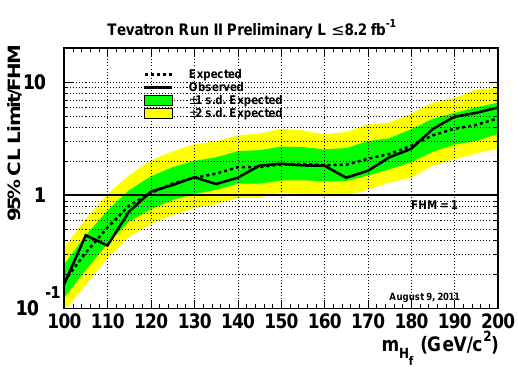
Fig. 8. The combined observed (solid black lines) and expected (dashed black lines) 95% C.L. upper limit on σ ( p ¯ p B ( H W + W − ) are shown in a fermiphobic model as a function → of the Higgs boson